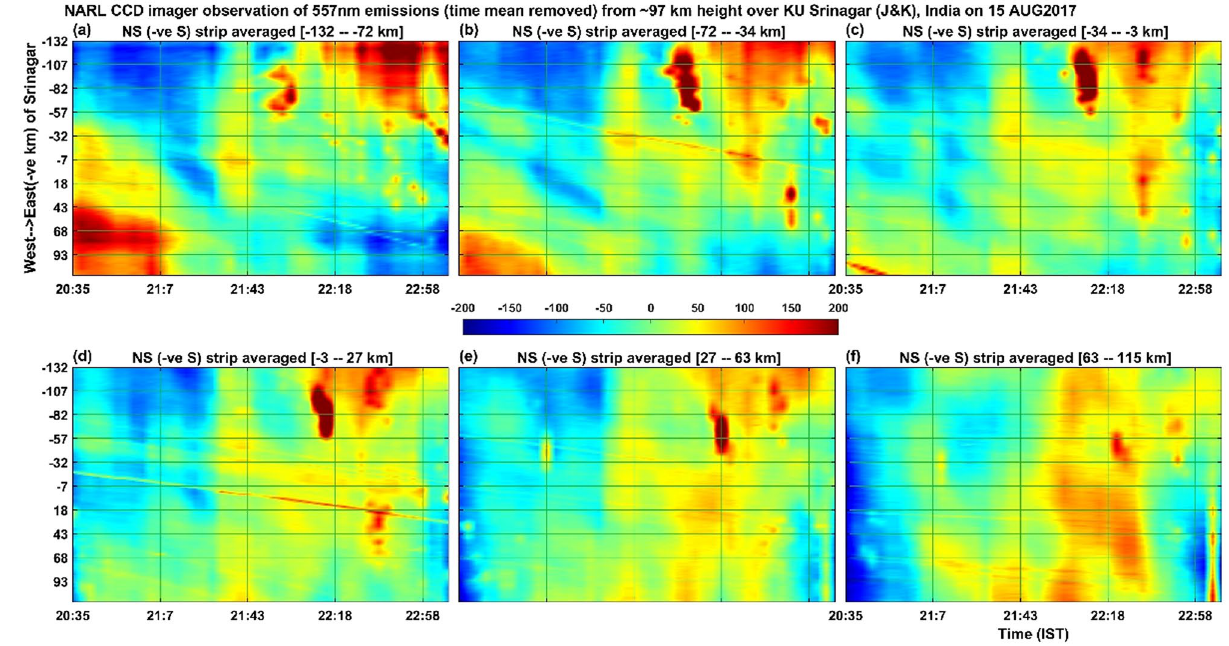
Figure 7. Illustrates the same as the Fig. 5 but for the 557.7 nm emissions of atomic oxygen from the height of about 97 km. The colour bar values (emission intensity) are given in W sr −1 m −2 which can be converted into